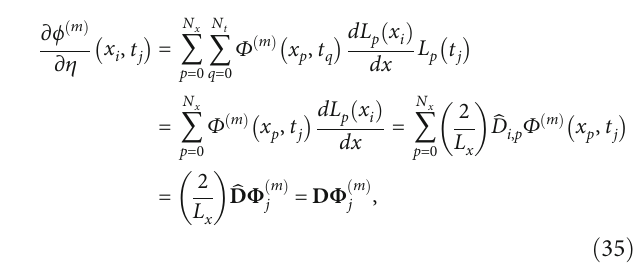
Figure 9: Concentration pro fi le for di ff erent values of N δ = NR = 0 : 2, Sc = 0 : 6, and Pr = 1